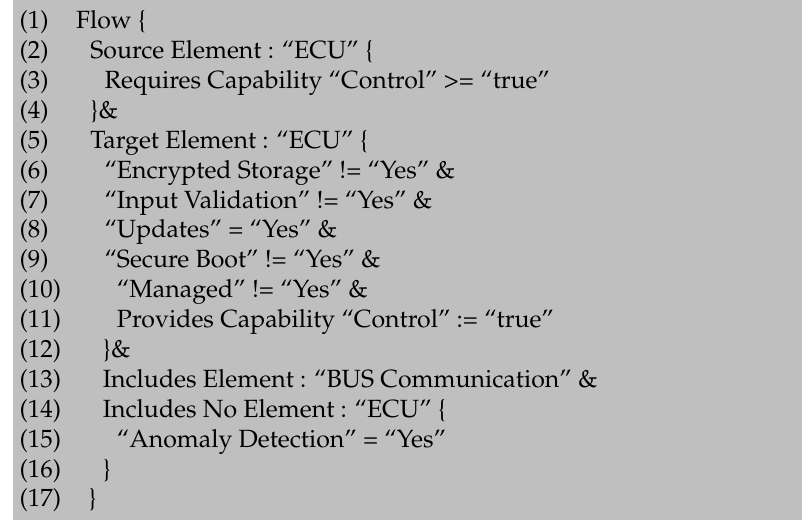
Figure A5. Anti-Pattern for Rule 5.